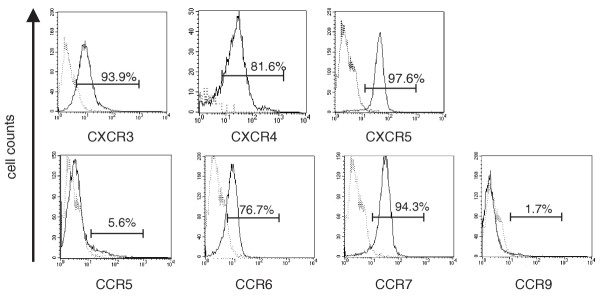
Expression of chemokine receptors in peripheral blood B cells from a healthy donor. Flow cytometric plots show chemokine receptor expression on CD19+ B cells. For each of the chemokine receptors tested the percentage of positive B cells is indicated. Isotype control (dotted line) is included.